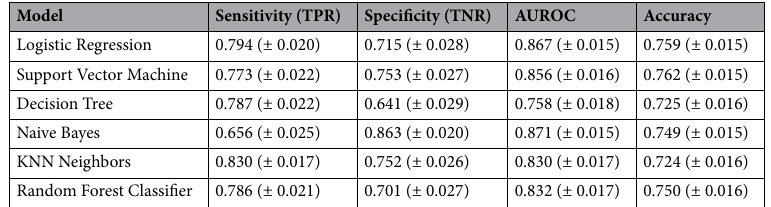
Table 4. Binary classifier nested ten-fold CV metrics.